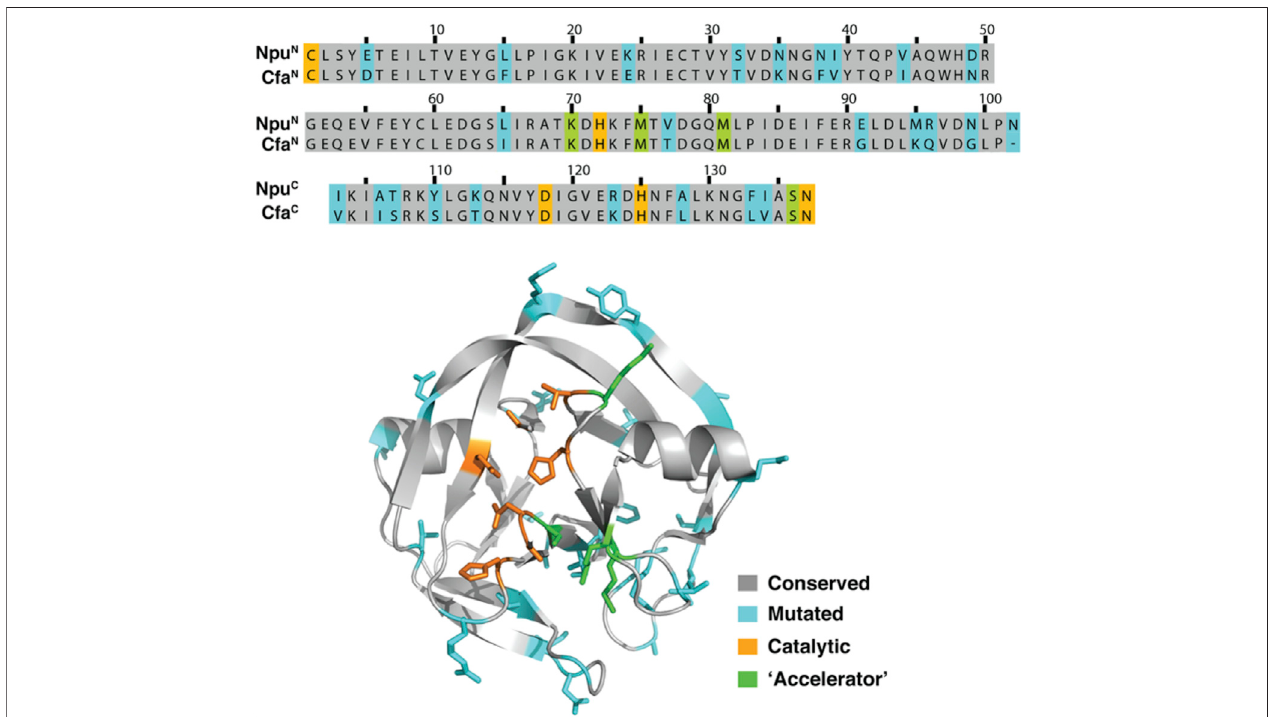
FIGURE 11 | Comparison of the sequence alignment of Npu DnaE intein (PDB ID 4KL5) and engineered Cfa split intein presented by scientists at Princeton University(Muiretal.,2020a;PatentApplicationPublicationNo.:US2020/0055900A1;prioritizedin2016and fi ledin2017).Acomputer-generatedmodelofthedesign of the Cfa split intein, according to an embodiment of the invention, has also been shown, where the general effects of various mutations are indicated (Aranko et al., 2013; Stevens et al., 2016; Gramespacher et al., 2018). Reproduced with ACS permission from Stevens et al., 2016.